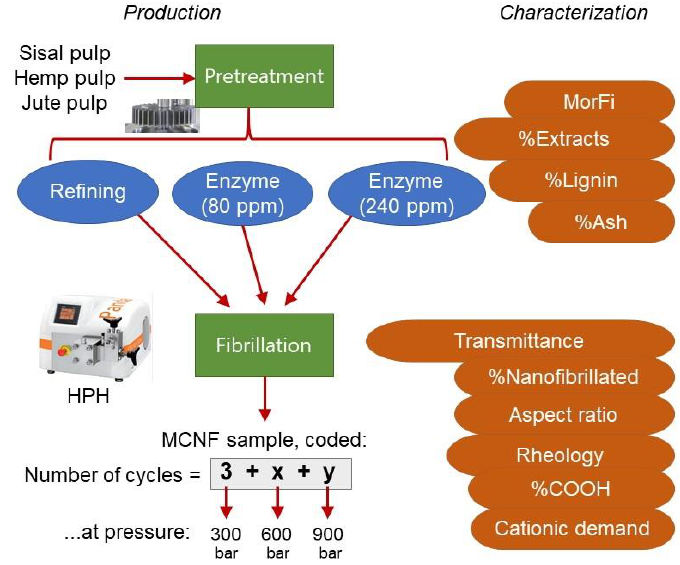
Figure 1. General experimental layout.